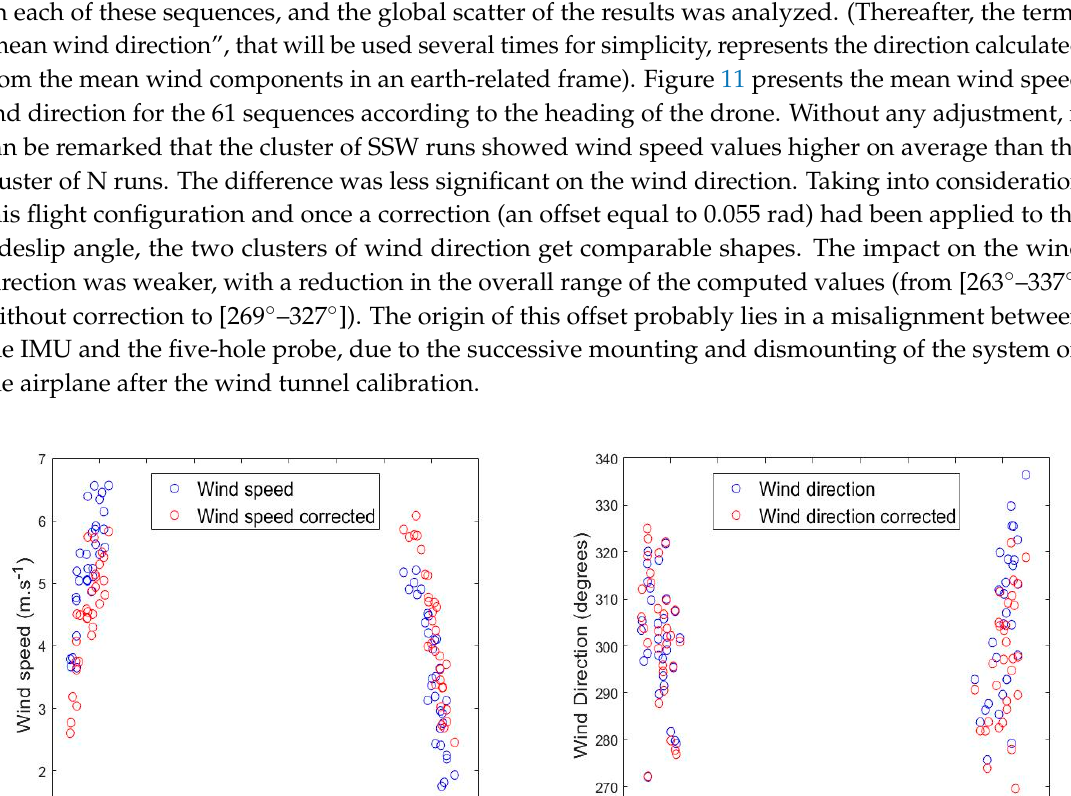
Figure 10. Relative humidity ( a ), temperature ( b ), and wind speed ( c ) measured by OVLI-TA during a flight in Lannemezan on 24 March 2016. The time window is from 12:35 to 13:27 (UTC).